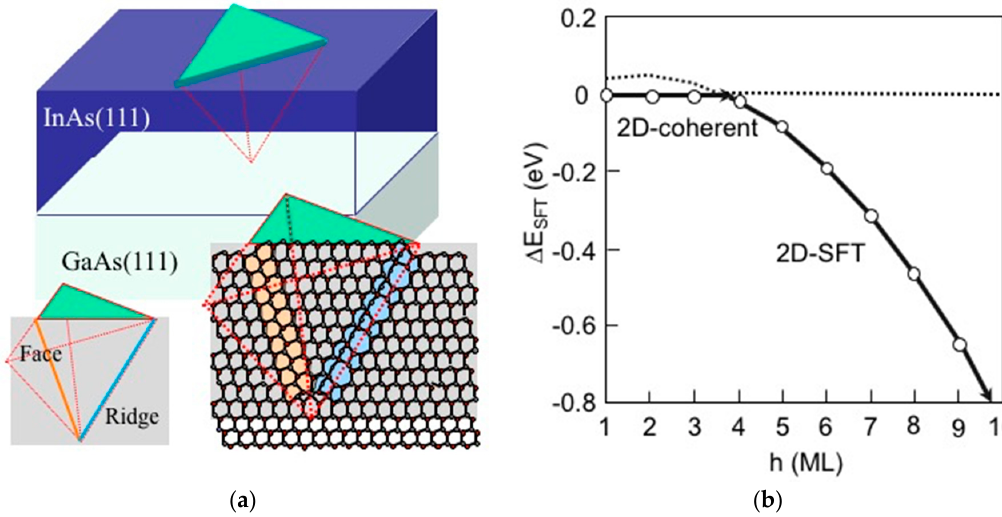
Figure 5. ( a ) Schematic of the 2D growth with formation of stacking-fault tetrahedron (SFT) consisting of ridge and face; ( b ) Calculated energy difference between the 2D coherent growth (2D-coherent) and the growth with SFT (2D-SFT) as a function of layer thickness h.